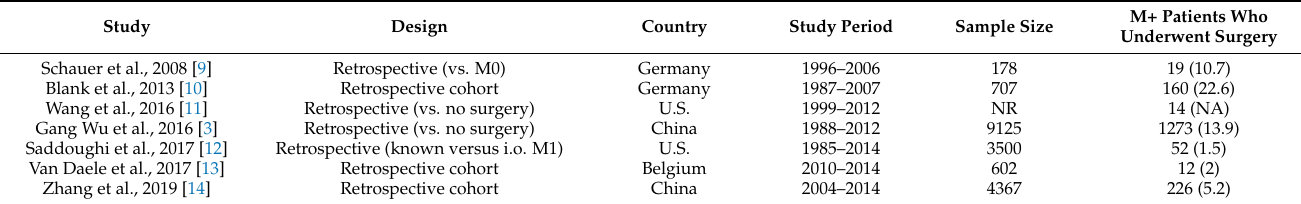
Table 1. Summary of included